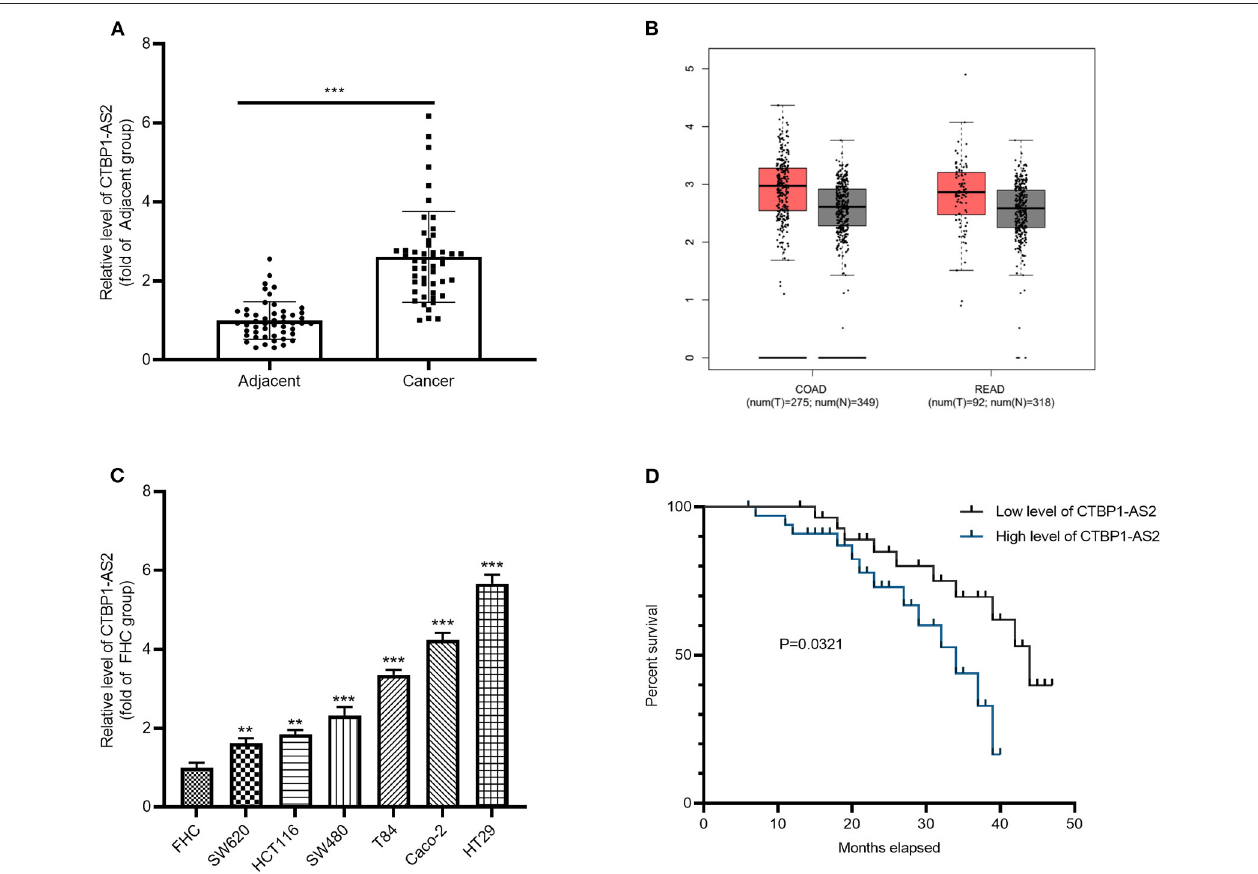
FIGURE 1 | Increased expression of CTBP1-AS2 in CRC tissues and correlation with poorer prognosis in patients with CRC. (A) Use of RT-PCR to measure CTBP1-AS2 expression in 50 CRC tissues and adjacent healthy tissues, *** p < 0.001. (B) Analysis of CTBP1-AS2 expression in COAD and READ tissues by GEPIA. (C) Evaluation of CTBP1-AS2 levels in healthy human intestinal mucosa FHC and CRC cancer cell lines SW620, HCT116, SW480, T84, Caco-2, and HT29 by RT-PCR, ** p < 0.01, *** p < 0.001 vs. FHC group. N = 3. (D) . Kaplan–Meier analysis of the association between CTBP1-AS2 level and the survival in patients with CRC. CRC, colorectal cancer; COAD, colon adenocarcinoma; FHC, fetal human cell; GEPIA, Gene Expression Profiling Interactive Analysis; READ, rectal adenocarcinoma; RT, reverse